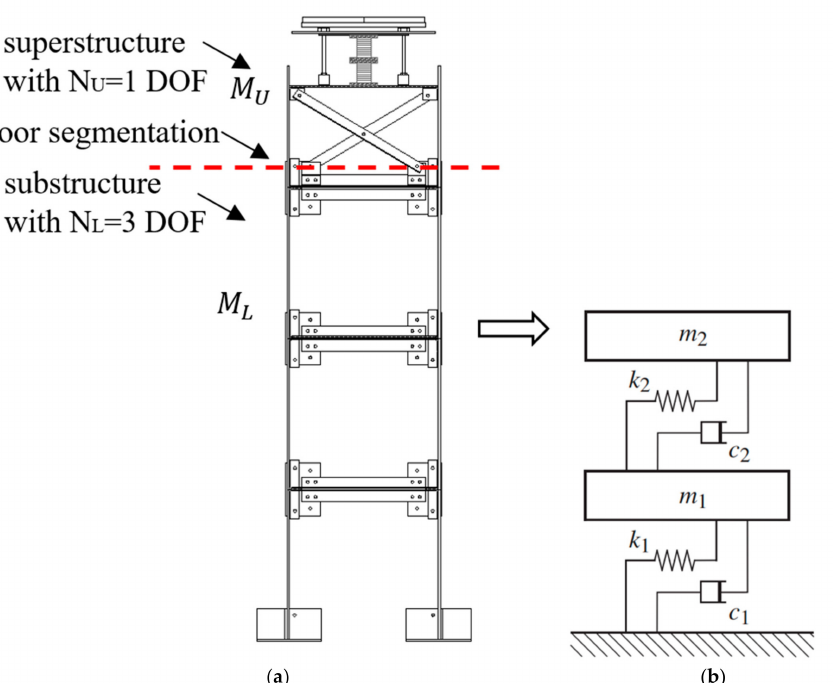
Figure 5. Structural models of the frame structure with inter-story isolation below the 4th floor: ( a ) 4-DOF model; ( b ) 2-DOF reduced-order model. Red dotted line indicates floor